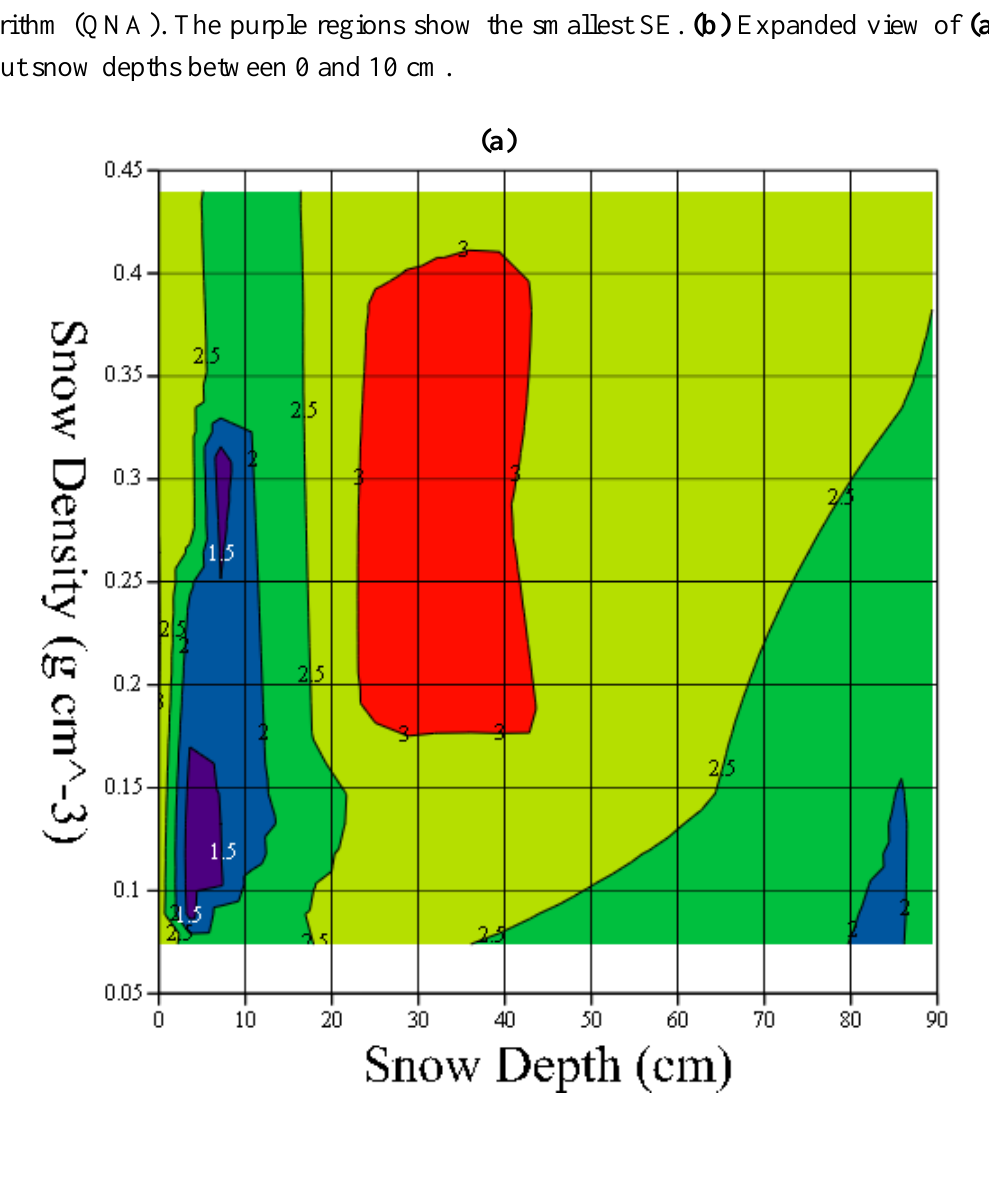
) with d ) in Table 2 using a quasi-Newton snow